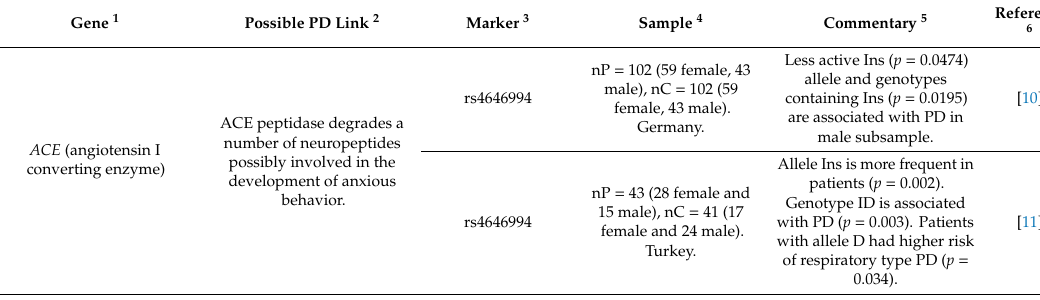
Table 1. Known panic disorder biomarkers and obtained by text-mining instruments supporting literature data. nP—number of patients, nC—control sample volume.